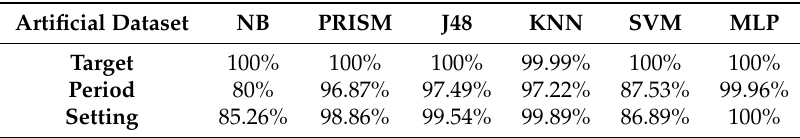
Table 9. Comparison of classification accuracy